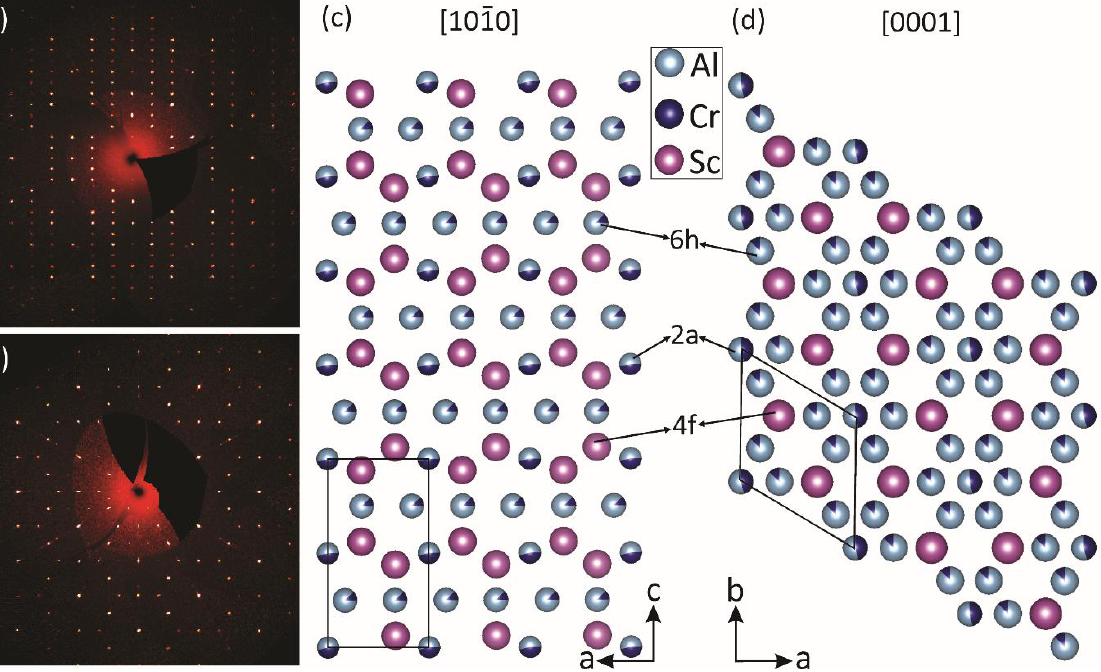
Figure 6. Single-crystal analysis of a grain of the Al 2 − x Cr x Sc ternary phase shown in two low-index zone axes: ( a ) [011̅0] and ( b ) [0001] . The crystal structure that was deduced from the single-crystal analysis is shown on the right with its unit cell projected along the ( c ) [101̅0] and ( d ) [0001] zone axes, as indicated in the top part of the figure. The double colouring of the blue circles is in proportion to the occupancy factor of those sites.